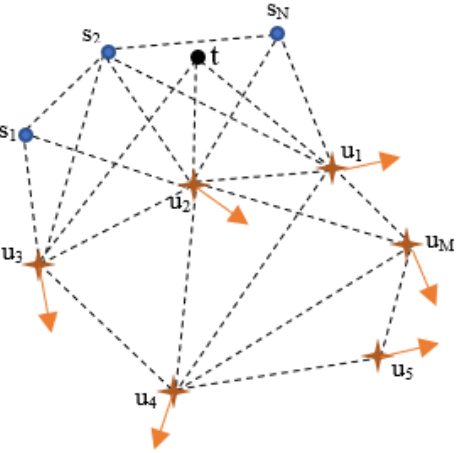
Figure 2. Sensor network. The dashed line depicts the inter-node measurements that are in the TOA communication range. Anchor nodes, transmitter, and unknown nodes are represented by blue circles, black circles, and brown